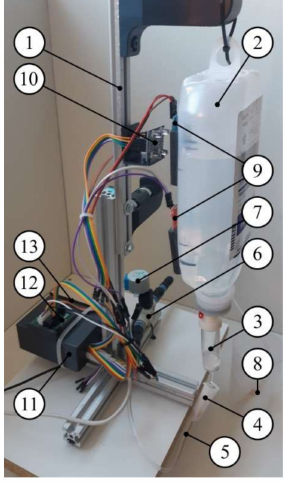
Figure 4. IV infusion dosing